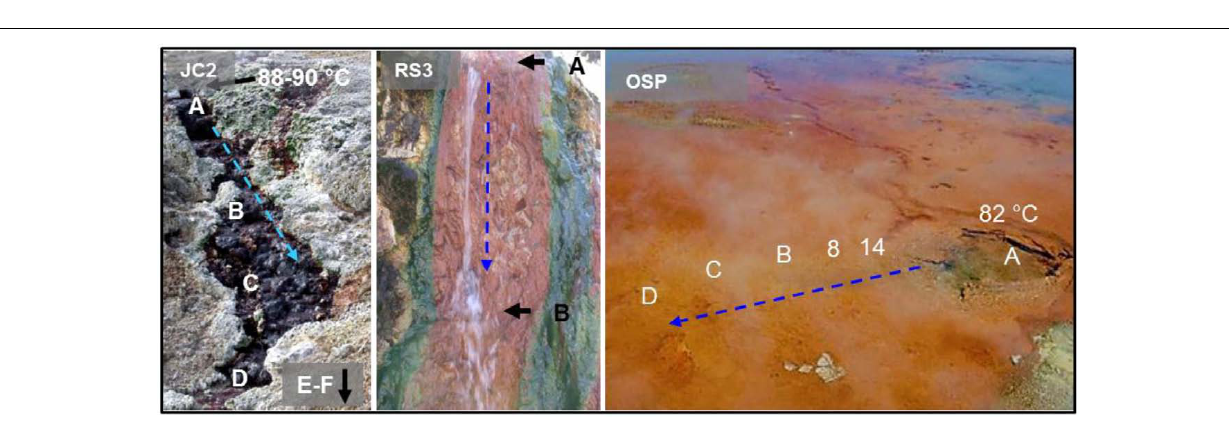
FIGURE 2 | Representative springs (JC2, RS3, and OSP) fromYellowstone National Park showing sampling points within the main flow channels, source water temperatures, and direction of flow channel (blue